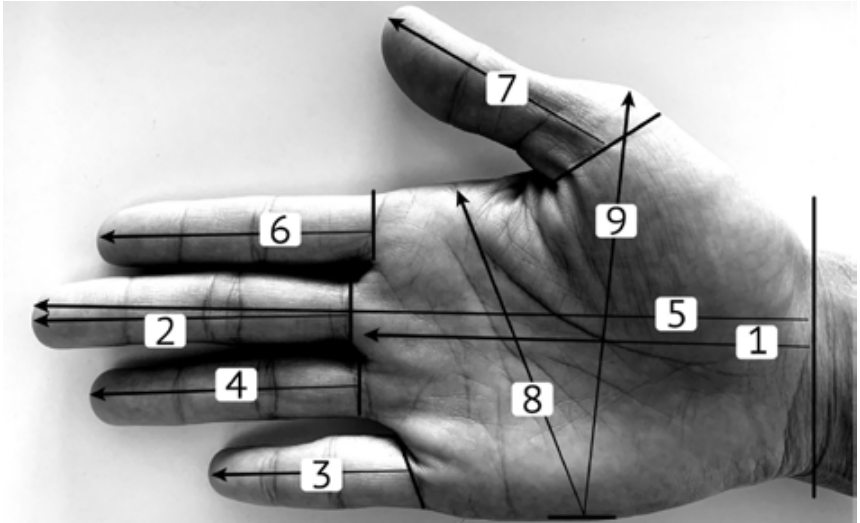
Figure 1. Hand dimensions (Hand anthropometric (1-palm length, 2-middle finger length, 3- little finger length, 4- ring finger length, 5-hand length, 6- index finger length, 7- thumb finger length, 8- minimum handbreadth, 9- maximum